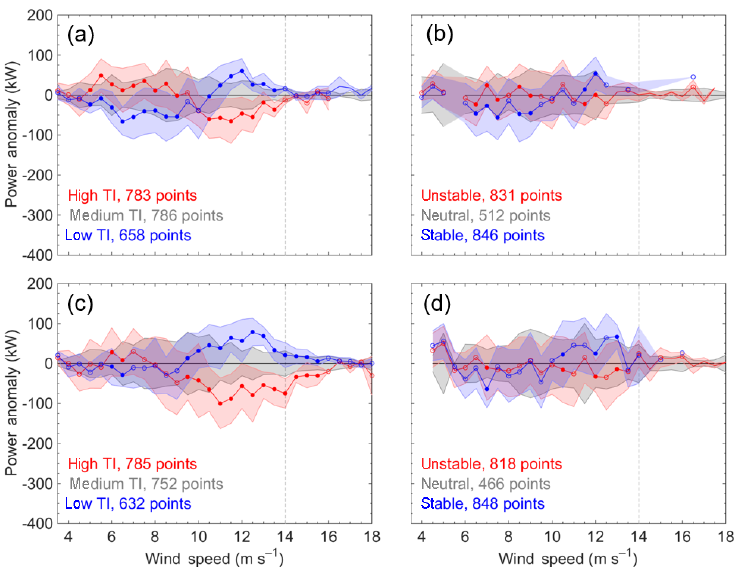
Figure 18. Nacelle anemometer power curves shown as the anomaly from the neutral or medium power curve of the (a) TI regimes and (b) R B regimes. Eighty-meter tower anemometer power curves shown as the anomaly from the neutral or medium power curve of the (c) TI regimes and (d) R B regimes. Median statistics are used to avoid outlier effects. Statistically distinct differences within each wind speed bin between the regimes are determined by the Wilcoxon rank sum test with a 1% significance level and denoted by closed circles. Includes data filtered for tower 80m wind speeds between 3.5 and 25.0ms − 1 , 87m wind directions between 235 and 315 ◦ , and for normal turbine operation. Envelopes represent ± 1MAD for each wind speed bin. The grey dashed line marks rated speed.